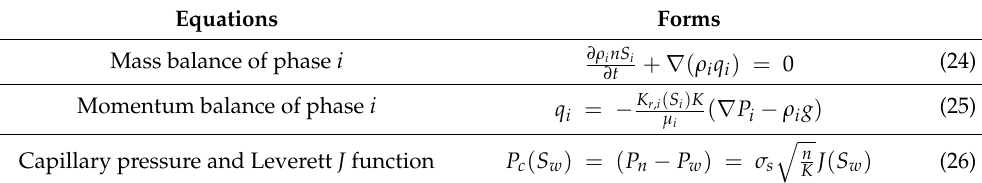
Table 4. The full governing equations for transient two-phase flow in porous media under equilib- rium. Equations Forms Mass balance of phase i Momentum balance of phase i Capillary pressure and Leverett J